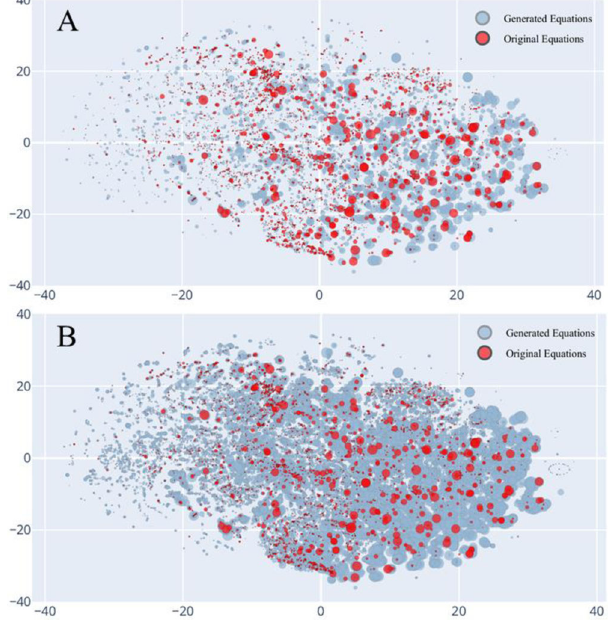
Fig. 4 T-SNE plot of the training dataset (original equations) and the generated dataset (generated equations). The size of the sphere is proportional to Δ G at standard conditions. A All 7000 equations from the training dataset and randomly sampled 7000 equations from the generated dataset. B 70,000 equations from the generated